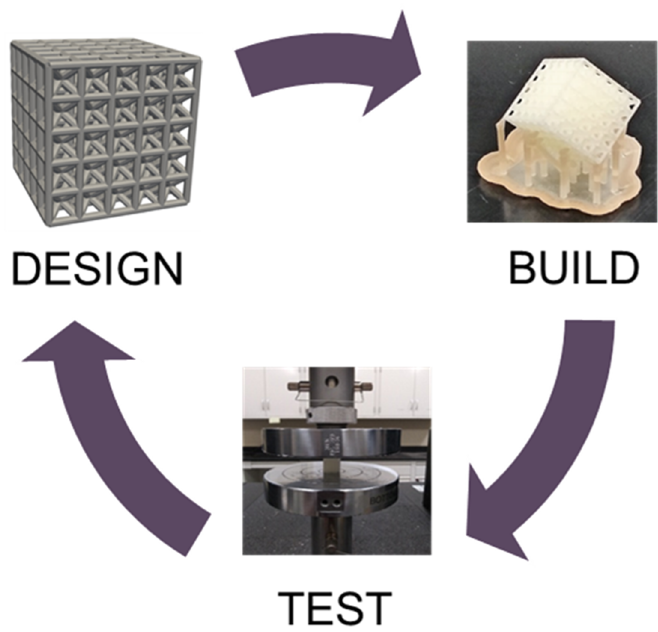
Figure 1. Design–build–test process for investigating 3D printed lattice mechanics.